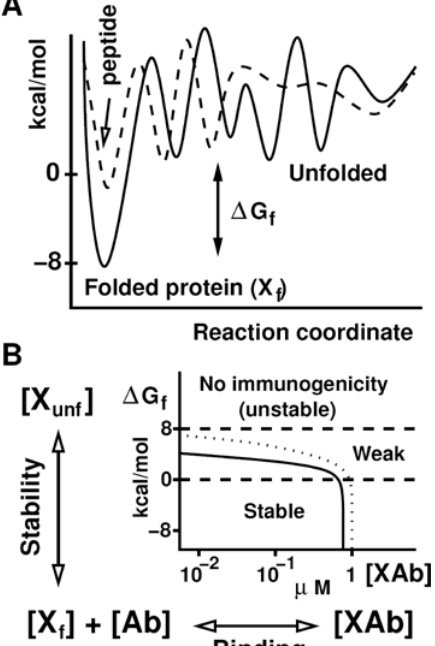
Figure 1. Thermodynamics and binding kinetics of a stable protein compared to weakly stable peptides sharing the same binding motifs. (A) This sketch represents the folding free energy landscape of a stable protein (solid line) relative to a less stable protein/ peptide (dashed line) sharing the same folded motif. (B) Coupling of protein folding free energy and protein (X)-antibody (Ab) binding kinetics is shown in the designated graph where the amount of protein- antibody complex (XAb) complex formed is plotted as a function of the folding stability of X, with fixed concentrations of X and Ab equal to 1 m M. The solid line reflects association and dissociation rates of 10 6 M 2 1 s 2 1 and 10 2 1 s 2 1 (K d =100 nM), respectively, whereas the dotted line indicates a dissociation rate of 10 2 3 s 2 1 (K d =1 nM). Dashed lines delineate different binding regimes as a function of peptide/ protein stability, identifying a ‘‘stable’’ category with D G X , 0 kcal/mol that corresponds to peptides capable of binding to antibody with the same affinity as protein. Above this threshold exist ‘‘weakly stable’’ peptides that can trigger anti-protein antibodies but are unable to compete with protein for antibody binding. Peptides exceeding the folding free energy boundary of the latter category are unstable and therefore